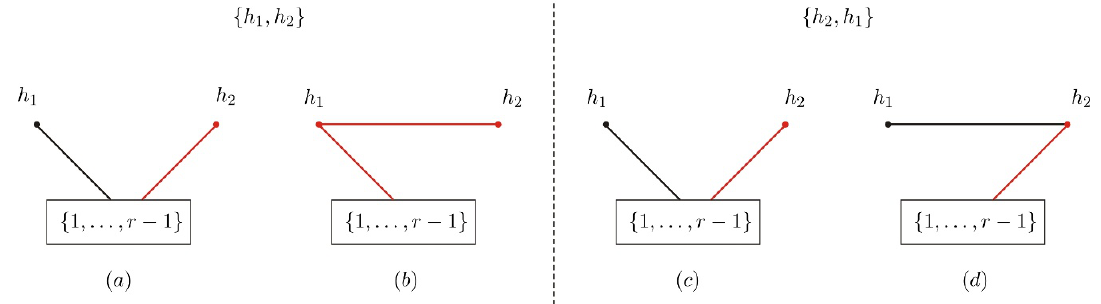
Figure 1 . All possible graphs with H = f h 1 ; h 2 g and reference order R = f h 1 ; h 2 g . Graphs ( a )